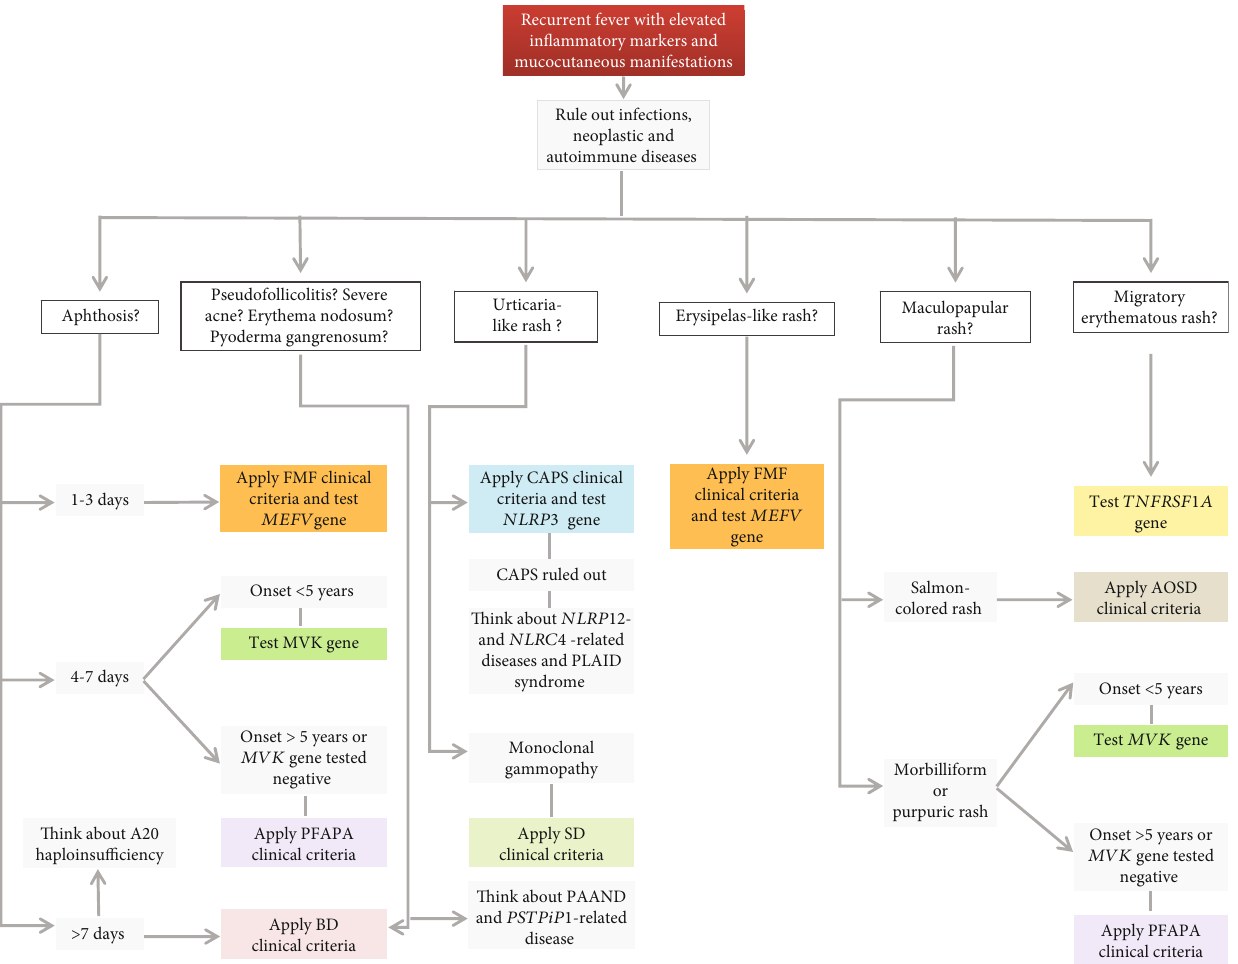
Figure 2: Diagnostic fl ow chart for main autoin fl ammatory diseases displaying recurrent fevers and mucocutaneous manifestations. List